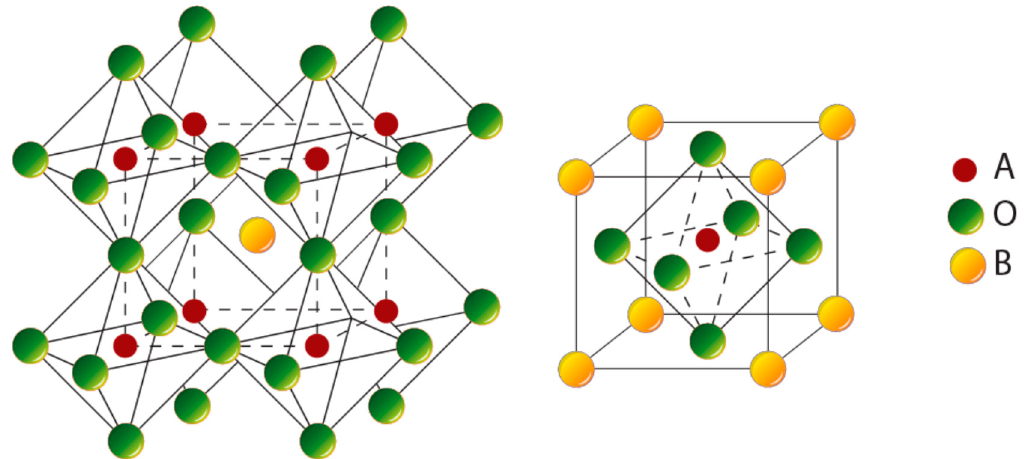
Figure 1. A schematic of the cubic perovskite structure ABO 3 .